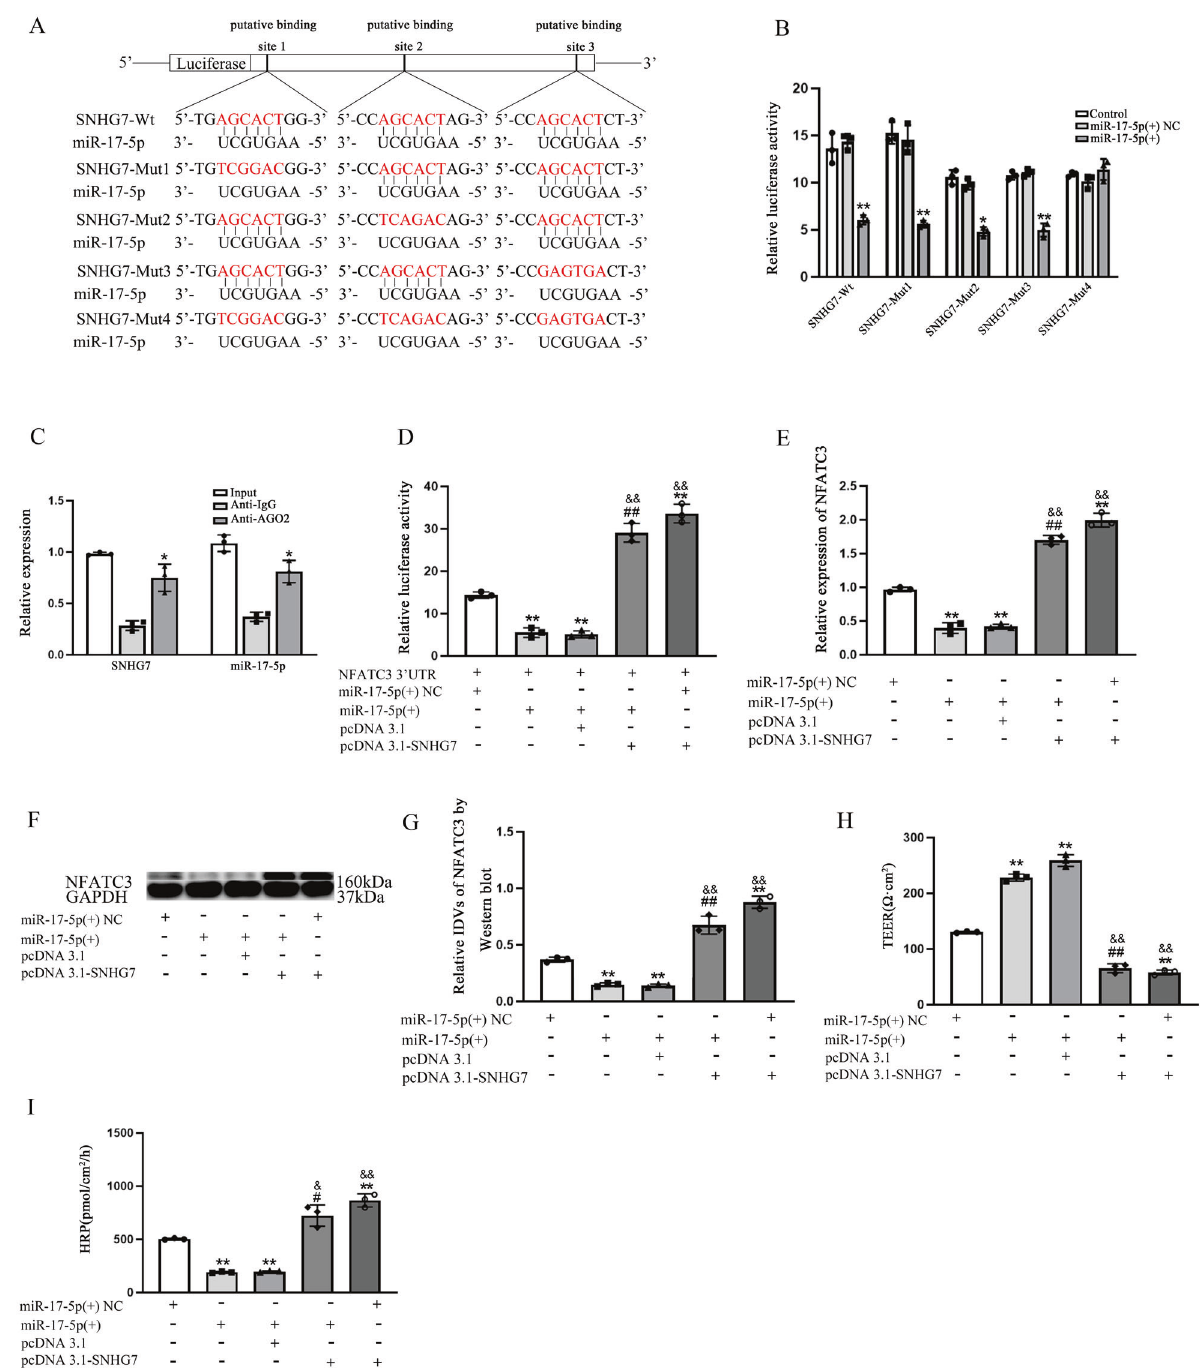
Fig. 7 SNHG7 acting as a miR-17-5p ceRNA to regulate NFATC3 expression. A , B Dual-luciferase reporter assays were performed to detect putative binding sites between miR-17-5p and SNHG7. * p < 0.05 and ** p < 0.01 vs. miR-17-5p( + )NC, data were presented as mean ± SD ( n = 3, each). C RIP assays were applied to identify miR-17-5p in SNHG7-RISC complex. * p < 0.05 vs. anti-IgG group, data were presented as mean ± SD ( n = 3, each). D Dual-luciferase reporter assays were utilized to measure the competing endogenous RNA activity of SNHG7. ** p < 0.01 vs. miR- 17-5p( + ) NC group. ## p < 0.01 vs. miR-17-5p( + ) + pcDNA3.1 groups . && p < 0.01 vs. miR-17-5p( + ) group, data were presented as mean ± SD ( n = 3, each). E – G The relative expression level of NFATC3 was measured via qRT-PCR and western blot. GAPDH was used as an internal control. ** p < 0.01 vs. miR-17-5p( + )NC group. ## p < 0.01 vs. miR-17-5p( + ) + pcDNA3.1 groups. && p < 0.01 vs. miR-17-5p( + ) group, data were presented as mean ± SD ( n = 3, each). H , I TEER values of BBB were presented as Ω cm 2 . HRP fl ux was calculated as pmol/cm 2 /h. ** p < 0.01 vs. miR-17-5p( + ) NC group. # p < 0.05 and ## p < 0.01 vs. miR-17-5p( + ) + pcDNA3.1 groups. & p < 0.05 and && p < 0.01 vs. miR-17-5p( + ) group, data were presented as mean ± SD ( n = 3, each).